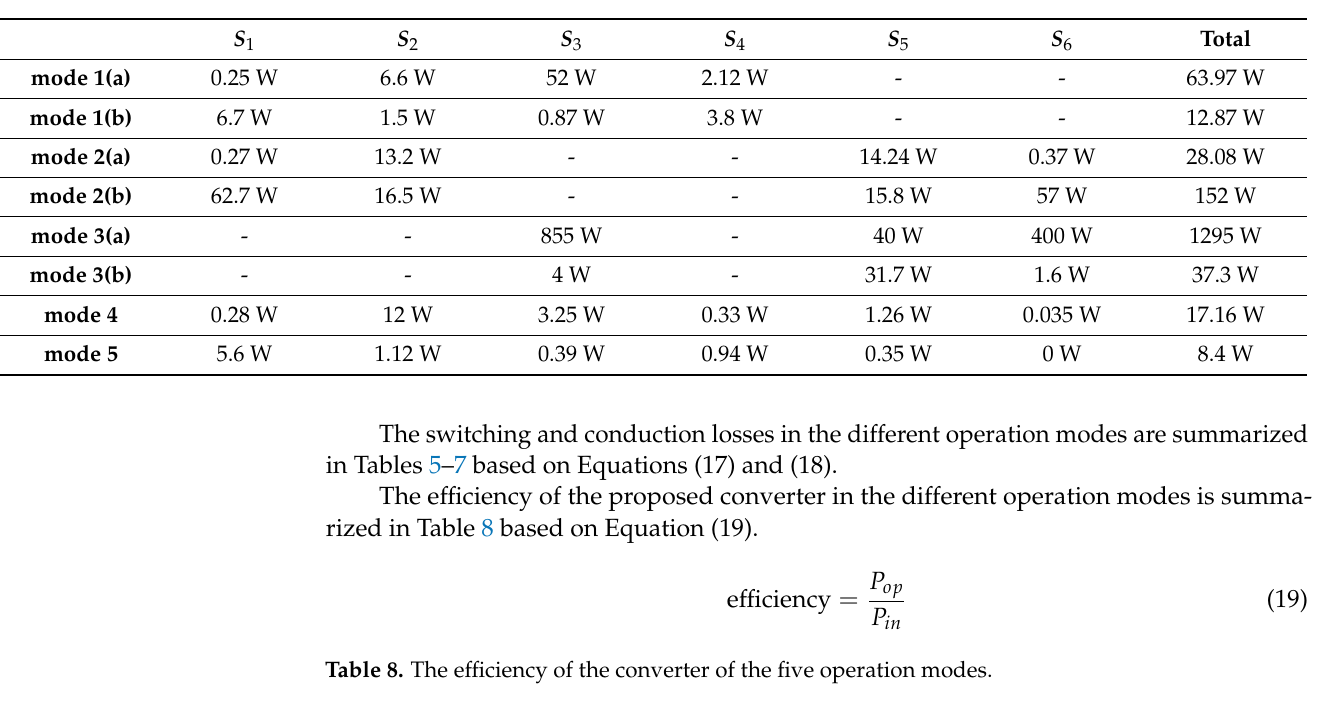
Table 7. Conduction losses of the five operation modes.